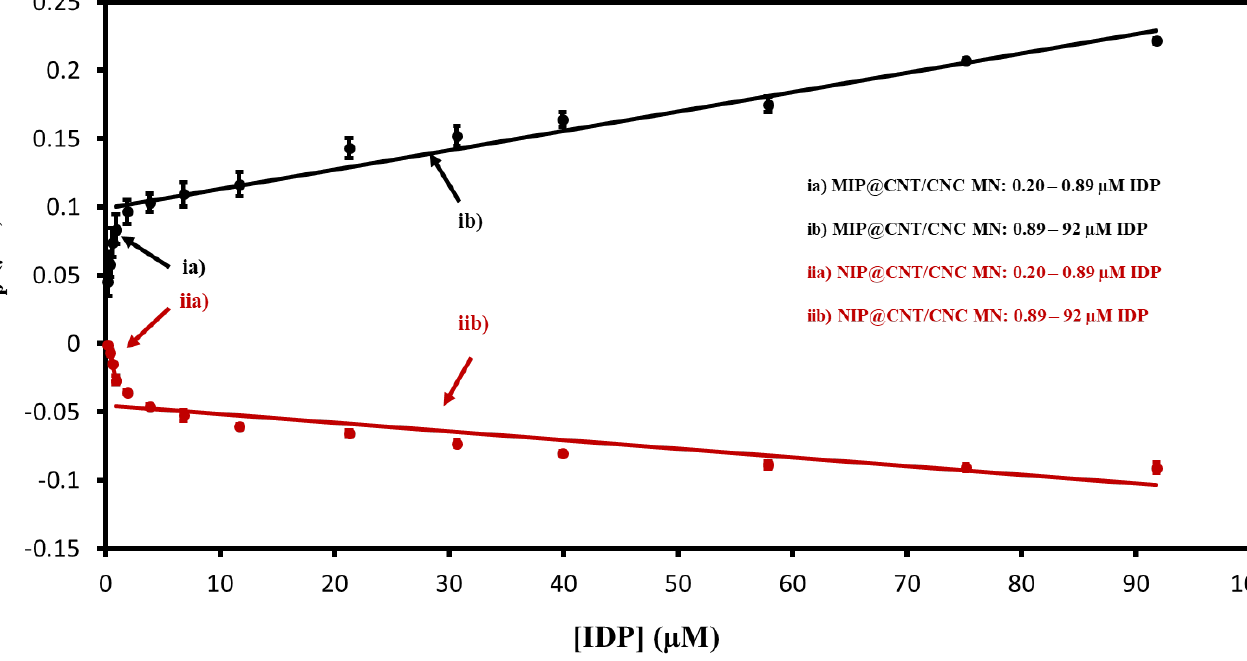
Table 3. Linear DPV calibration equations for MIP@CNT/CNC and NIP@CNT/CNC MN sensors in